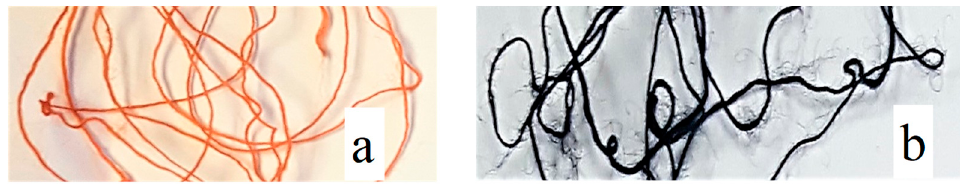
Figure 1. Examples of modified wool samples: ( a ) Slightly reddish after seleniumization, ( b ) black after complete formation of the copper selenide coating layer.